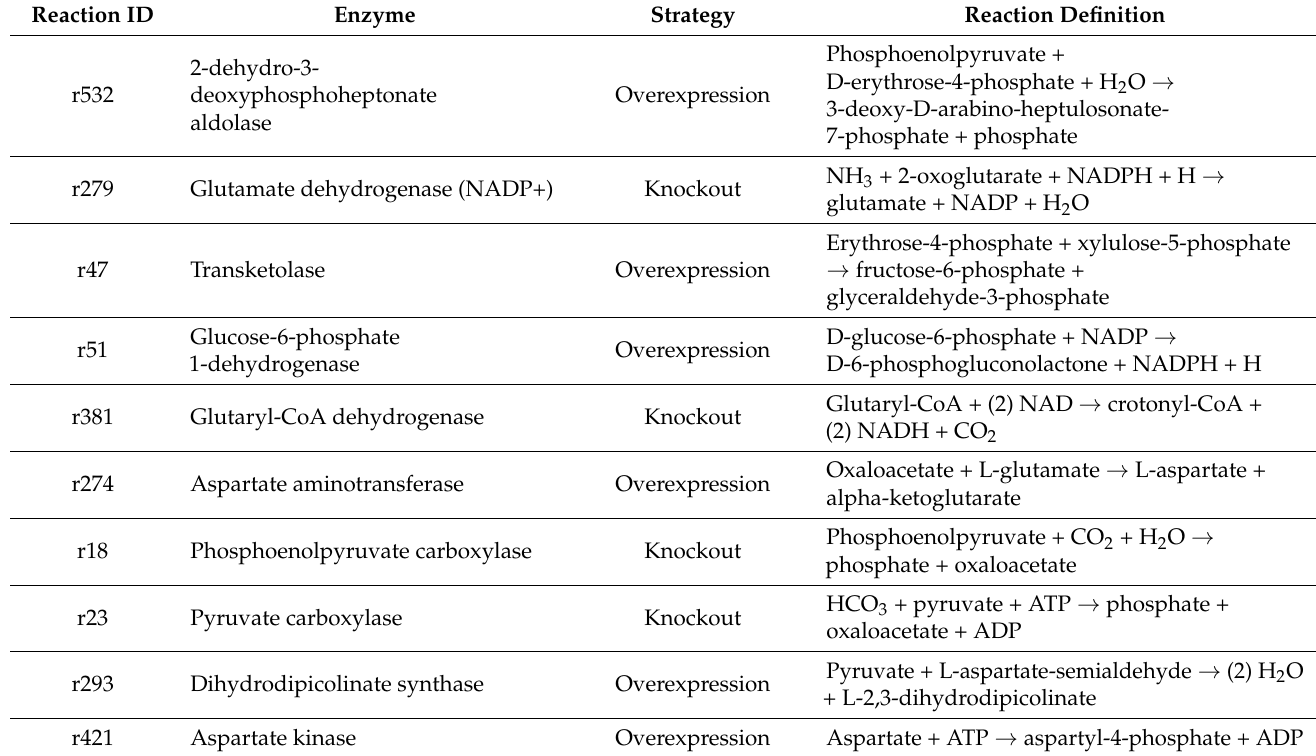
Table 2. Information of the potential limiting targets predicted using GSMM model in S. hygroscopicus